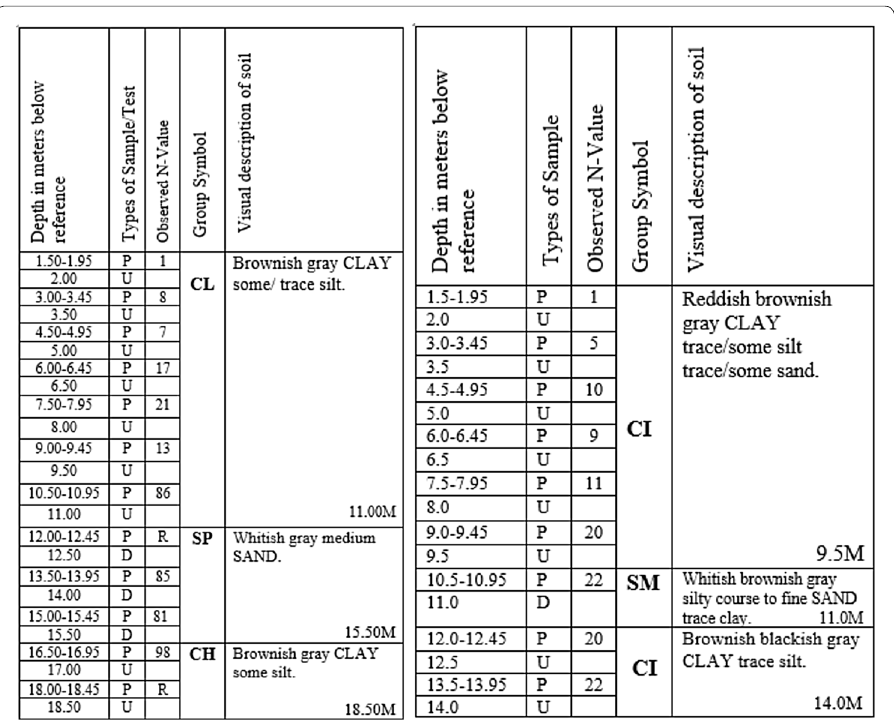
Fig. 3 Typical borehole stratigraphy and prevalent soils of northeastern region of